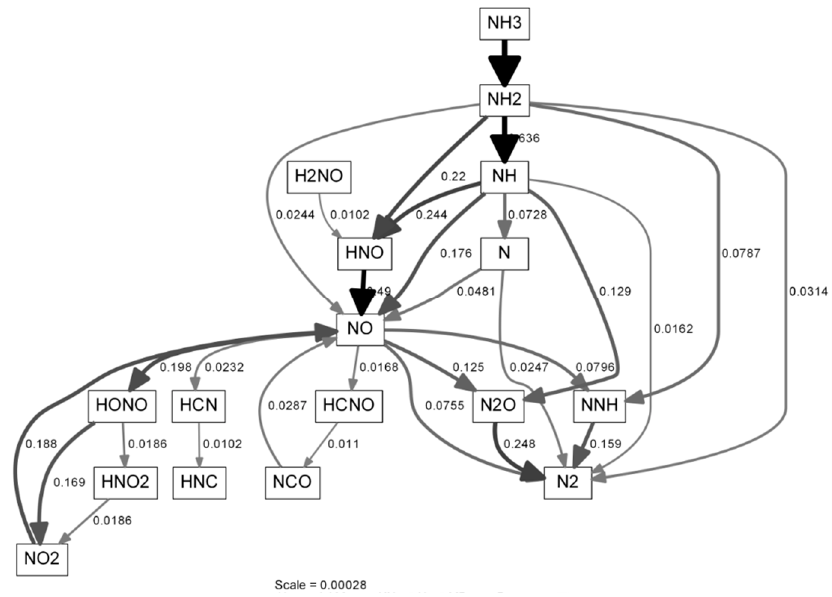
Figure 12. Reaction pathway diagram of nitrogen species for 5% NH 3 and φ = 0.71.